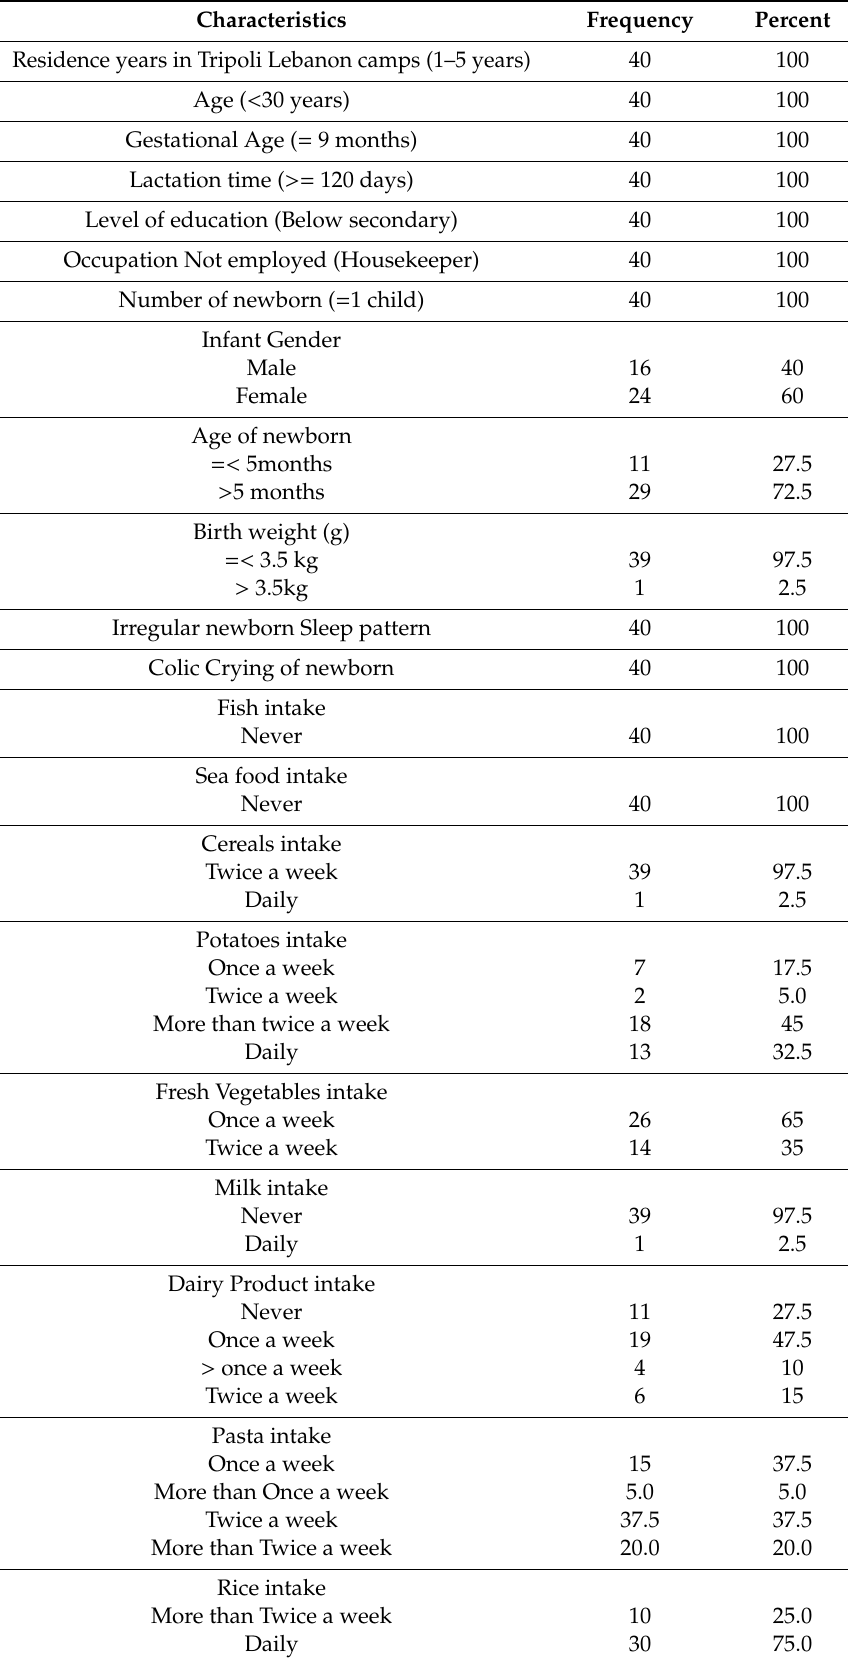
Table 3. Survey results of participating